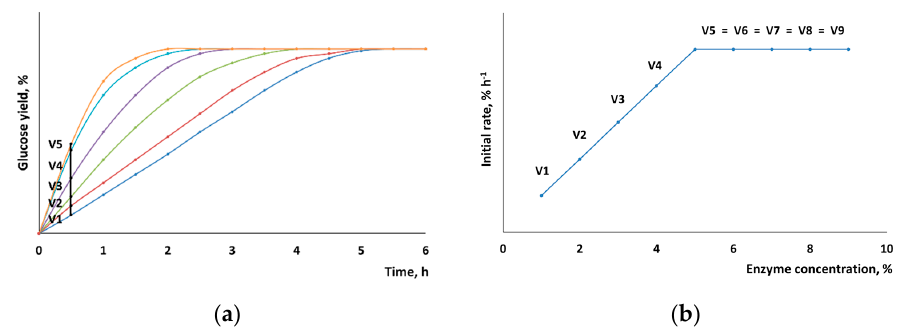
Figure 2. Determination of the maximum initial rate of hydrolysis by hypothetical kinetic curves: ( a ) a set of hypothetical kinetic curves with different substrate–enzyme ratios; ( b ) the initial rate of hydrolysis as a function of enzyme concentration.